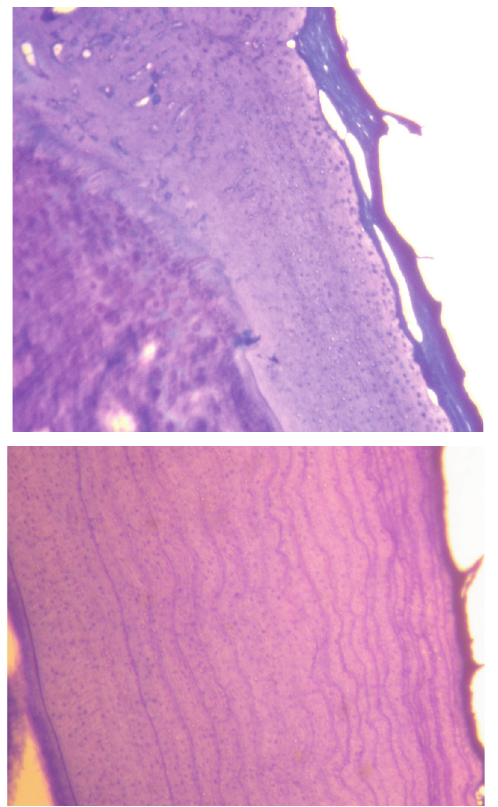
Fig. 6. Cemental layers in known-age har- bour seals from Inner Danish Waters: a) Seal no 245 born July 1985 with 2 GLGs in the cementum; died in third year of life ; b) Seal no 2 born June 1970 with 21 GLGs in the cementum; died in twenty second year of